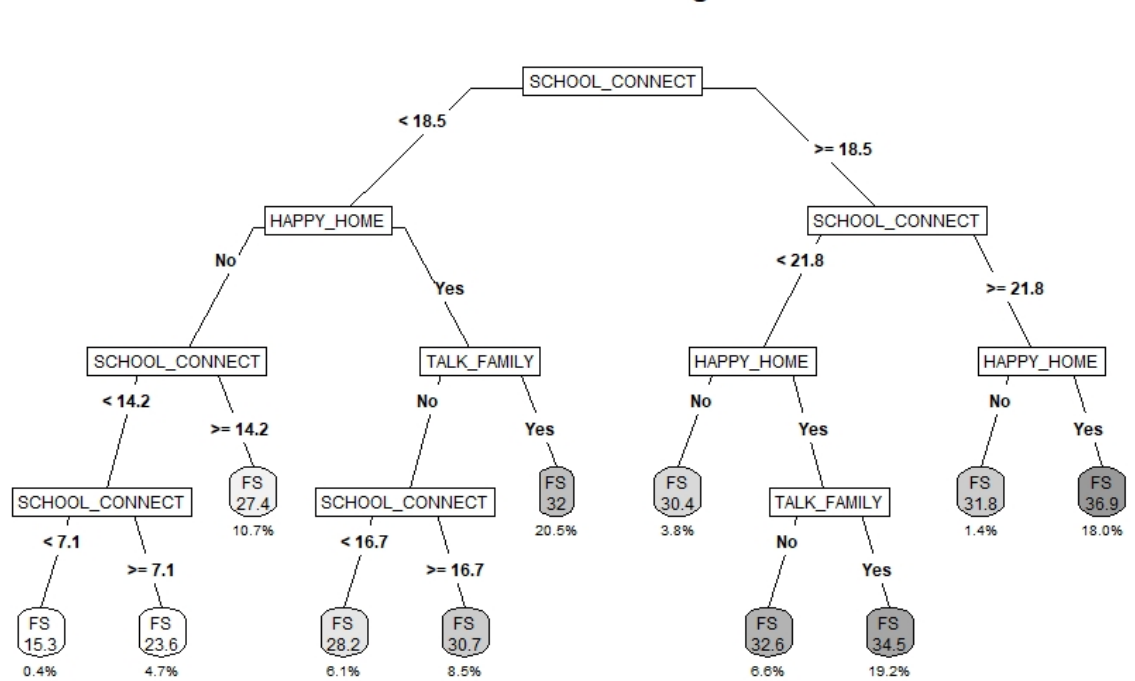
Figure 3. RE-EM Tree predicting average FS score for students participating in Year 7 (2018–2019) of the COMPASS Study ( N = 72,415). The FS score represents the average scale score within the subgroup. The percentage below represents the total percentage of the sample comprised by the